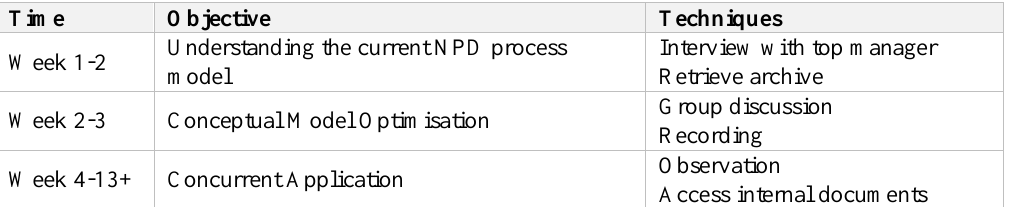
Table 2: Objective and Techniques at Different Stage Time Objective Techniques Understanding the current NPD process Week 1-2 Week 2-3 Week 4-13+ Concurrent Application